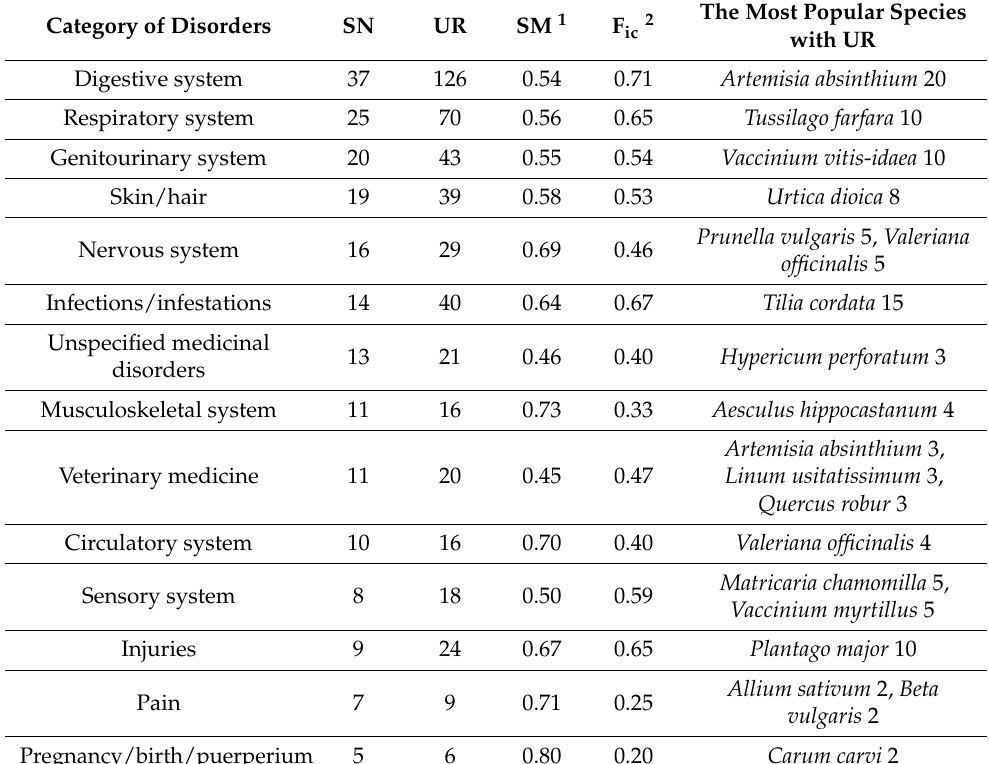
Table 3. Medicinal plant species number (SN), use reports (UR), use indices and the most popular plant species according to disorders